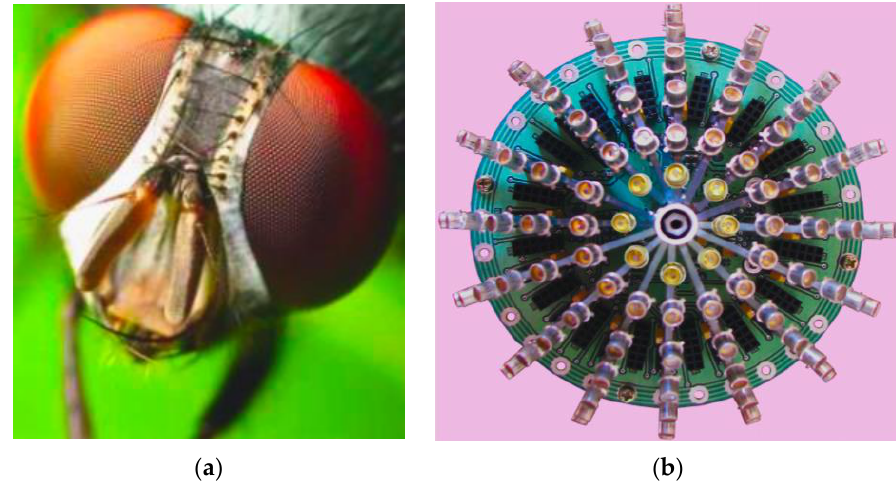
Figure 23. Optic sensors based on Elementary Motion Detection ( a ) Compound eye of a fly ( b ) A bio mimicked synthetic compound eye [80].